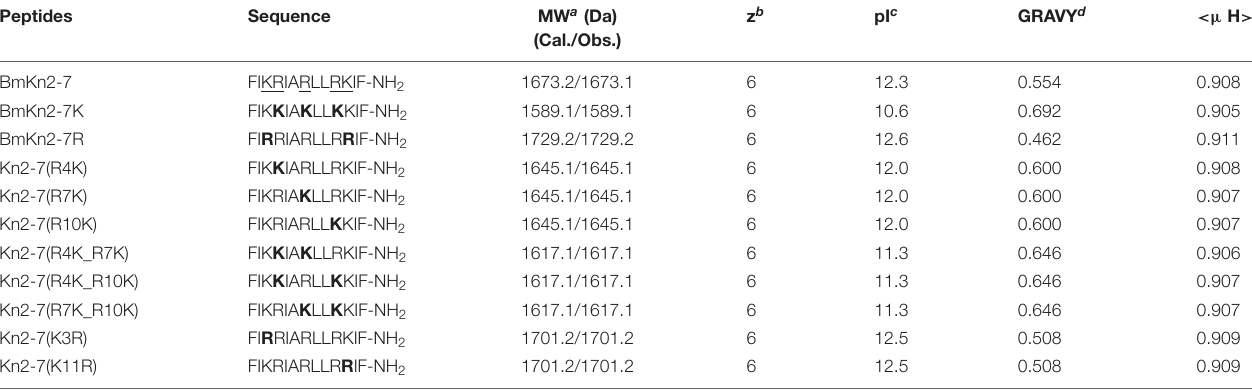
TABLE 2 | Physicochemical parameters of the peptides designed from BmKn2-7. Peptides